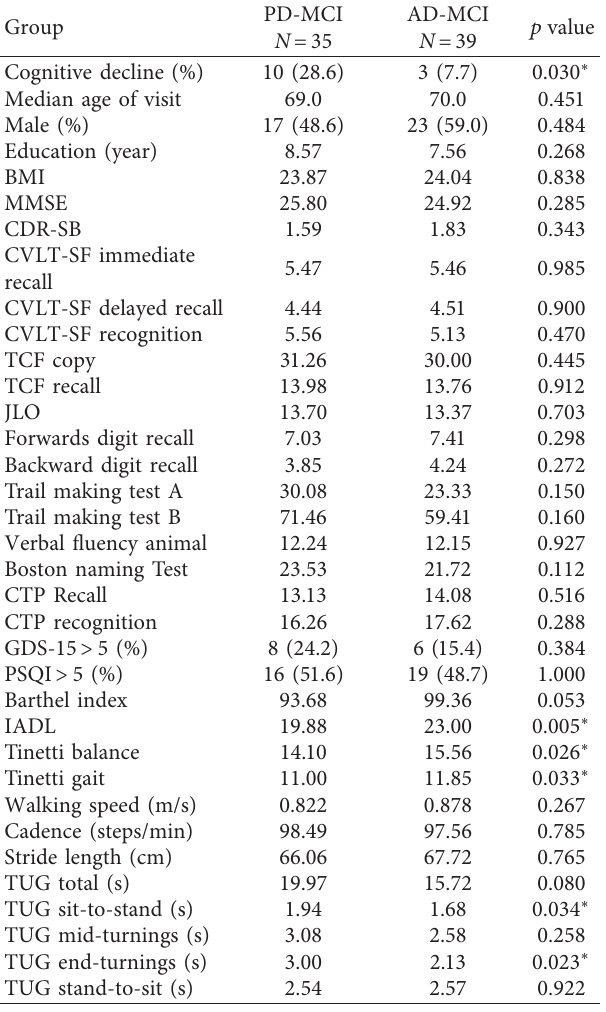
Table 1: Comparison of demographic and clinical characteristics between PD-MCI and AD-MCI